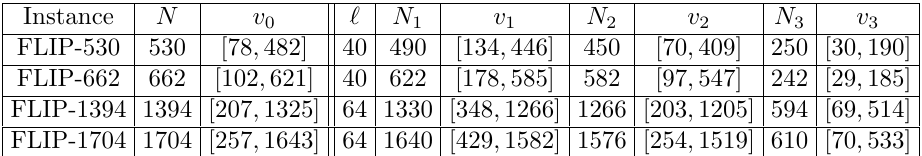
of FLIP instances, N refers to the number of variables, N,k NL EN,k ( f ) ≥ 0 . 499. ‘ refers to the number of canceled ( N ) k